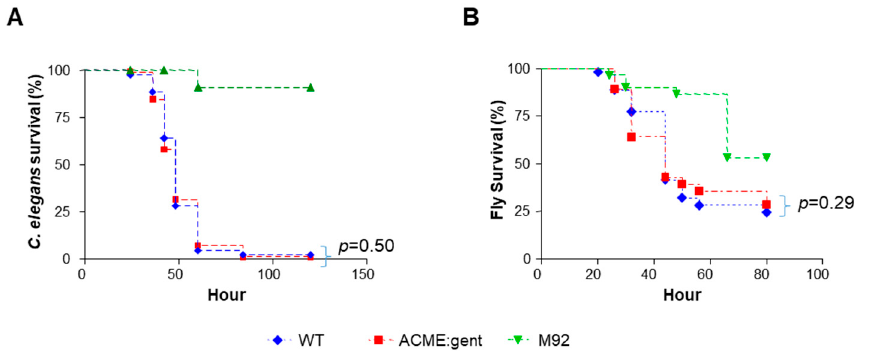
Figure 7. Strain 2406 WT and ∆ ACME showed similar virulence in the C. elegans and the D. melanogaster model. ( A ) Kaplan–Meier survival plots of nematodes fed with WT, ∆ ACME, and M92 (negative control). The survival curves of WT and ∆ ACME are not significantly different ( p = 0.50); ( B ) Kaplan–Meier survival plots of flies infected with WT, ∆ ACME and M92 (negative control). The survival curves of WT and ∆ ACME are not significantly different ( p = 0.92). Statistical significance was calculated by log-rank test.